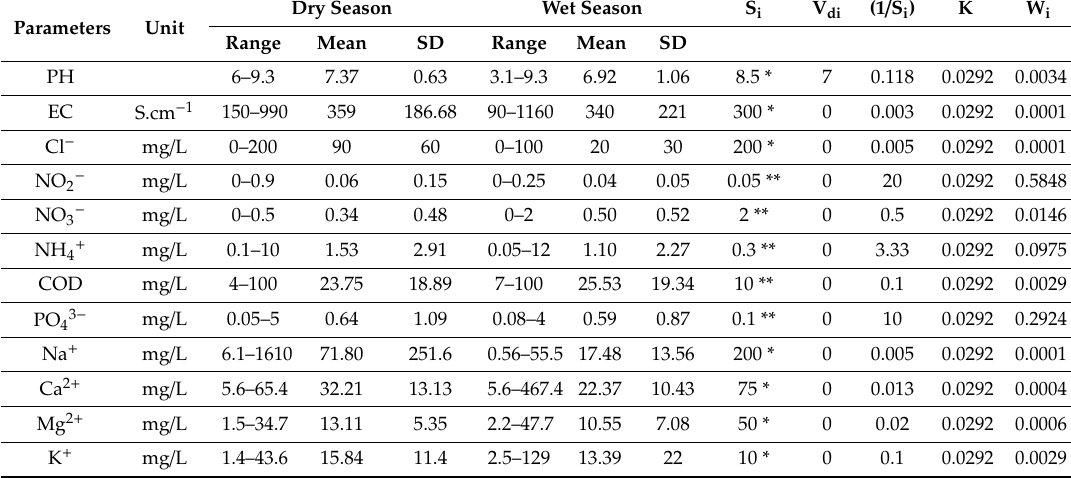
Table 6. Standards for drinking water and relative weight of parameters.